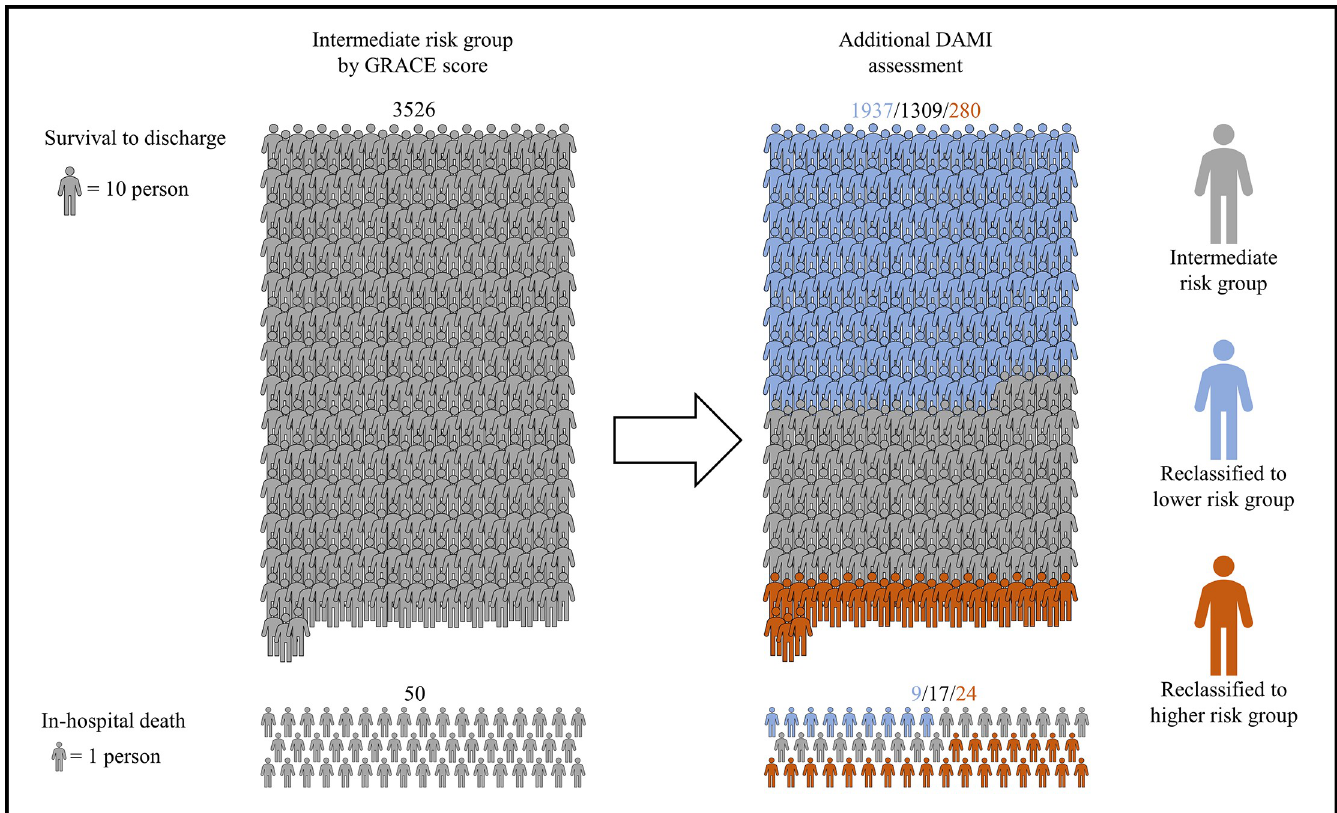
Fig 4. Reclassification of Individuals predicted to be at intermediate risk group by additional assessment of DAMI. DAMI denotes deep-learning-based risk stratification for the mortality of patients with AMI and GRACE denotes global registry of acute coronary event.